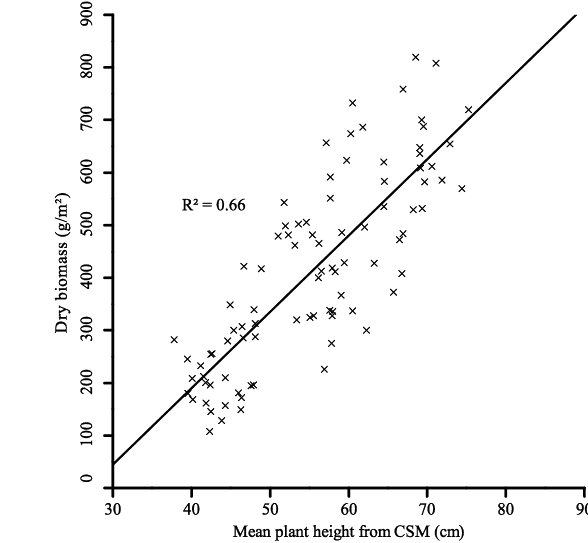
Figure 3. Difference between the mean CSM-derived and manually measured plant heights for the third campaign.